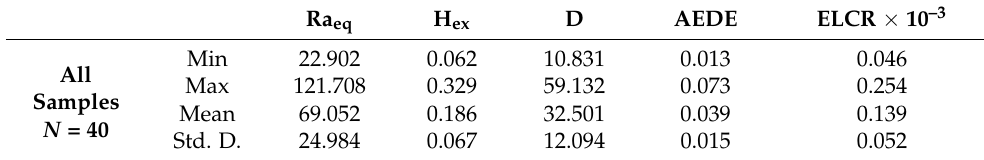
Table 5. Calculated radiological parameters.